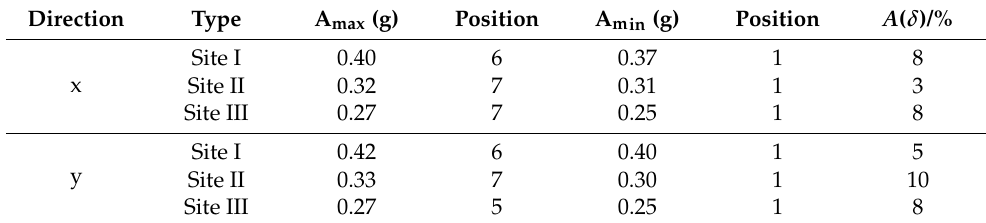
Table 2. Peak acceleration at different positions of the raft foundation.